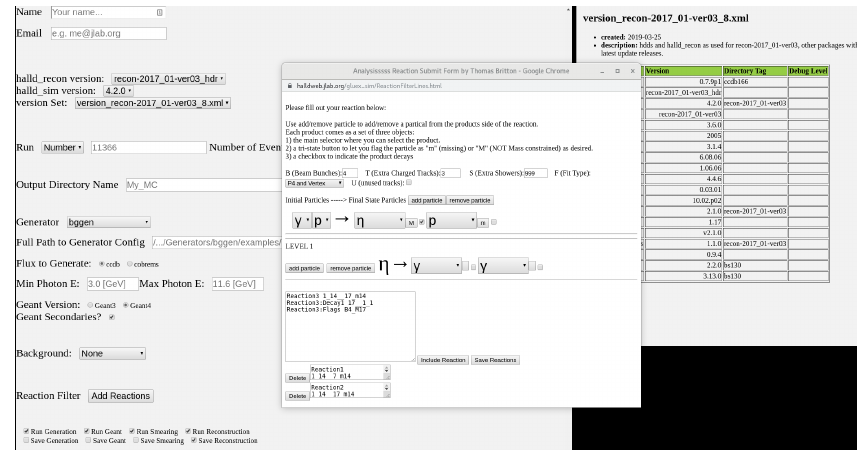
Figure 2. Shown is part of the dynamic web form which is used to submit a project to MCwrapper bot. This form includes knowledge of the GlueX software stack, a bevy of options, and integration with other GlueX systems (in the pop-up window). The system shown in the pop-up window allows users to set up reactions, in plain text, that will be searched for in the simulated data; mimicking the process real data goes